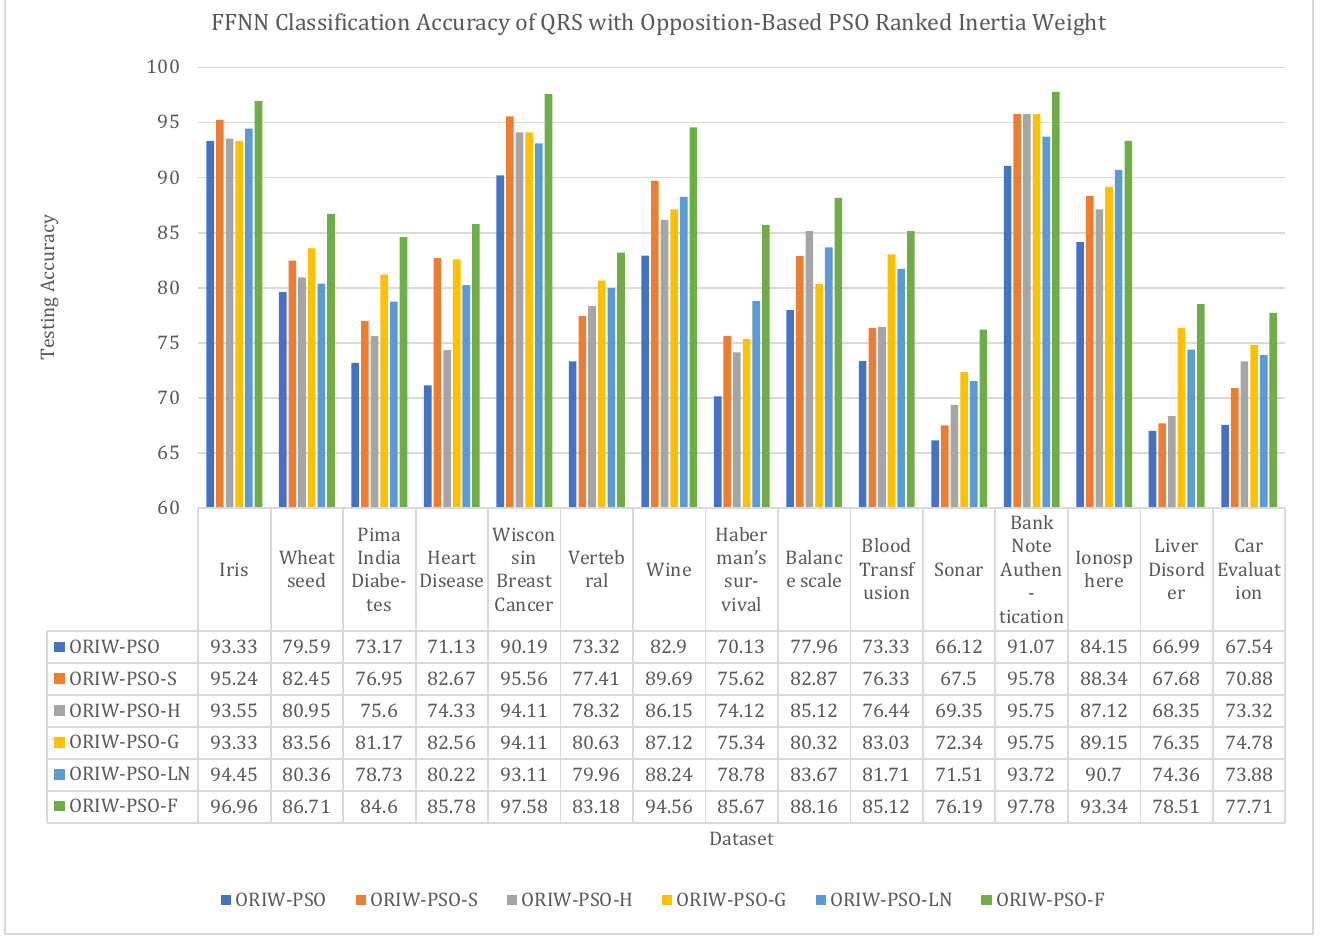
Figure 13. Testing accuracy result of QRS with opposition-based PSO ranked based inertia weight approaches. Table 4. One-way ANOVA result test of QRS with opposition-based PSO rank based inertia weight approaches.